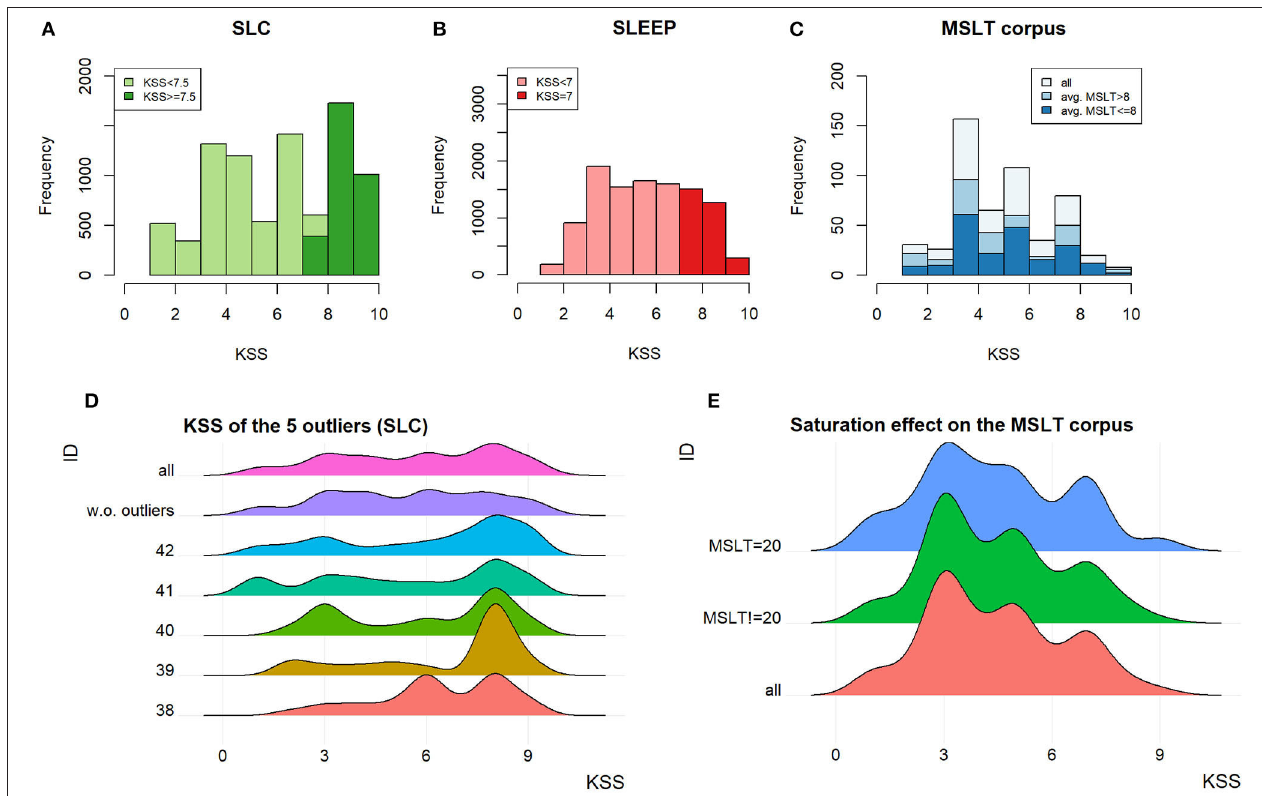
FIGURE 7 | (A–C) KSS distribution on the SLC, the SLEEP corpus, and the MSLTc. (D) KSS distribution of the outliers on the SLC and their impact on the distribution of the whole SLC. (E) Influence of the saturation on the KSS in the